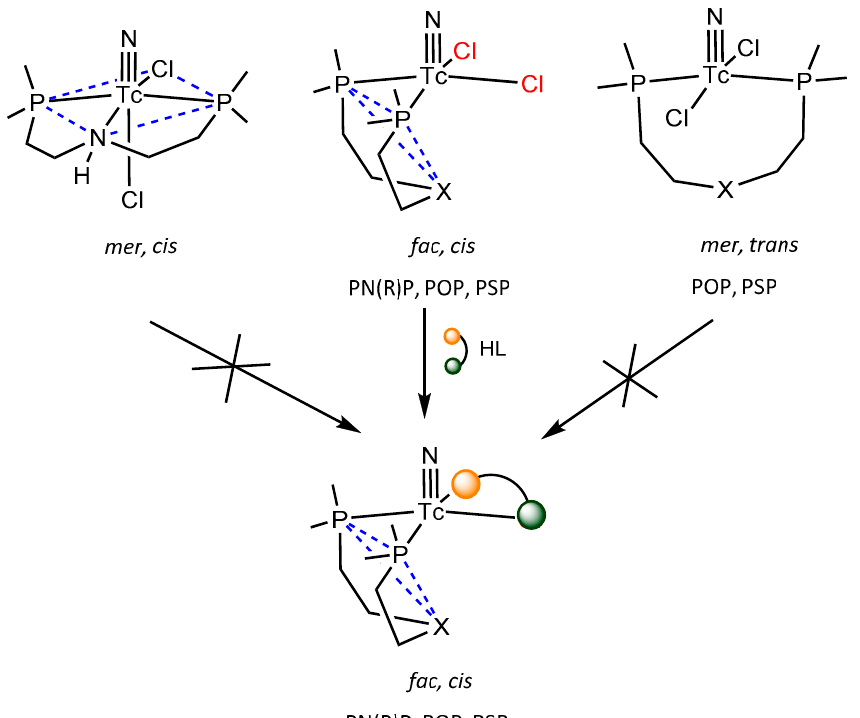
Figure 9. Stereochemistry of the various [TcNCl 2 (PXP)] species, along with their reactivity versus HL ligands.